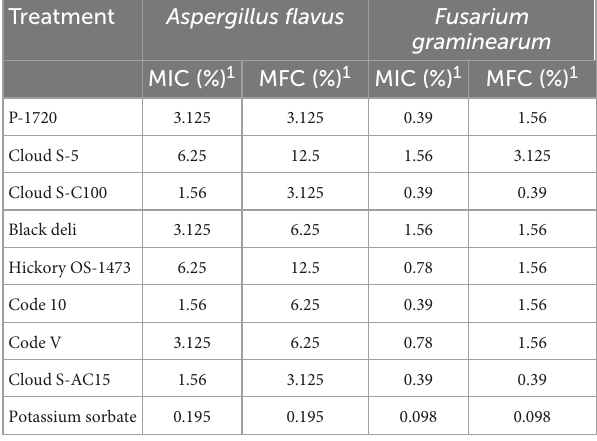
TABLE 4 Minimum inhibitory concentrations (MICs) and minimum fungicidal concentrations (MFCs) of liquid smoke preparations in nutrient broth (PDB) against Aspergillus flavus and Fusarium graminearum in comparison with potassium sorbate, a known mold